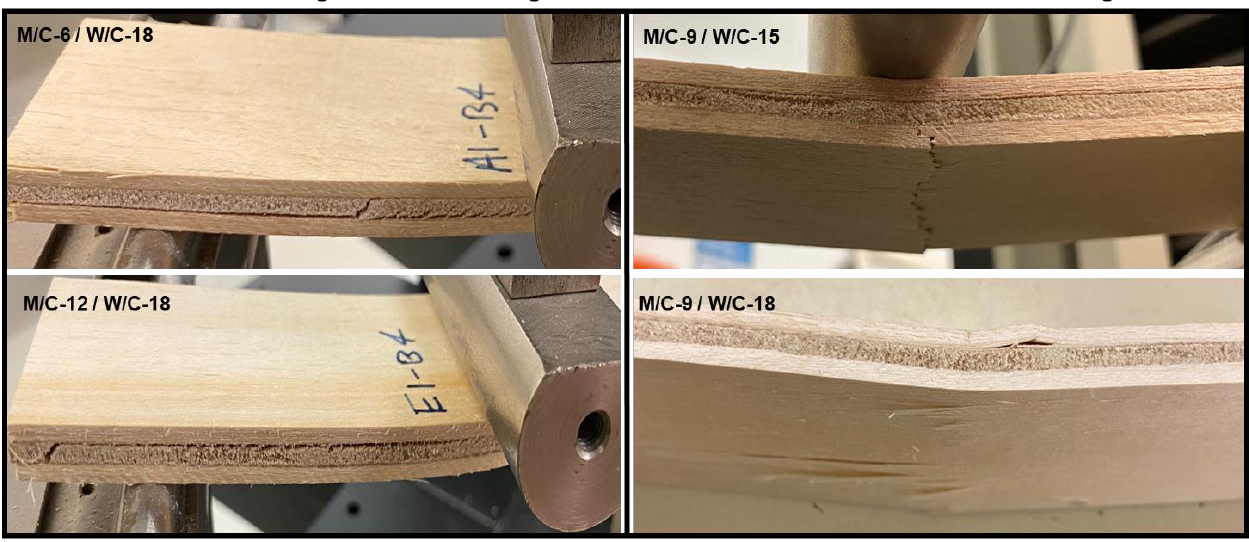
Figure 7. Failure modes of plywood samples during bending using MOC binders with different molar ratios of the components.